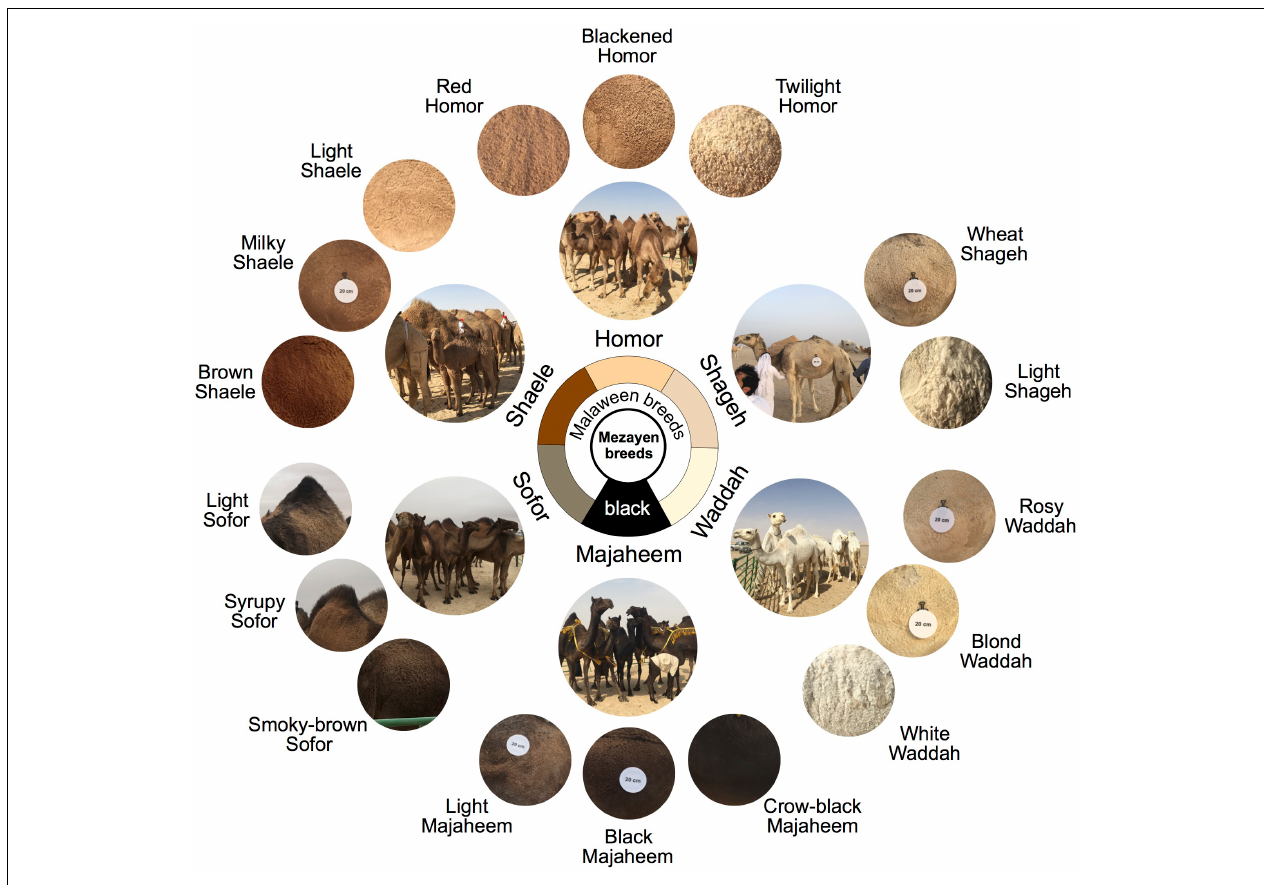
FIGURE 6 | Mezayen camel breeds of the Arabia Peninsula and their coat colors. The six breeds are primarily divided into black vs. Malaween breeds. This division is based on coat color and morphological characteristics (e.g., ear shape and tail length). The black breed is Majaheem whereas the Malaween camels are further divided into five breeds based their coat color. The Malaween breeds, ranging from dark to light, are as follows: Sofor, Shaele, Homor, Shageh, and Waddah. The outer (small) circles represent the “sub-colors” of each breed. The Majaheem sub-colors are crow-black, black, and light. The Sofor sub-colors are smoky-brown, syrupy, and light. The Shaele sub-colors are brown, milky, and light. The Homor sub-colors are red, blackened, and twilight. The Shageh sub-colors are wheat and light. The Waddah sub-colors are rosy, blond, and white. Coat color circles come from the Cdrom Archive photographs and were extracted from the part of the lateral torso that is below the hump. The white disks are reference scales (20 centimeters in diameter). Breed photos were taken by Hasan Alhaddad during Mutair Cultural Festival 2017, Kuwait. Coat color circles were extracted from Cdrom Archive photos (collected by the